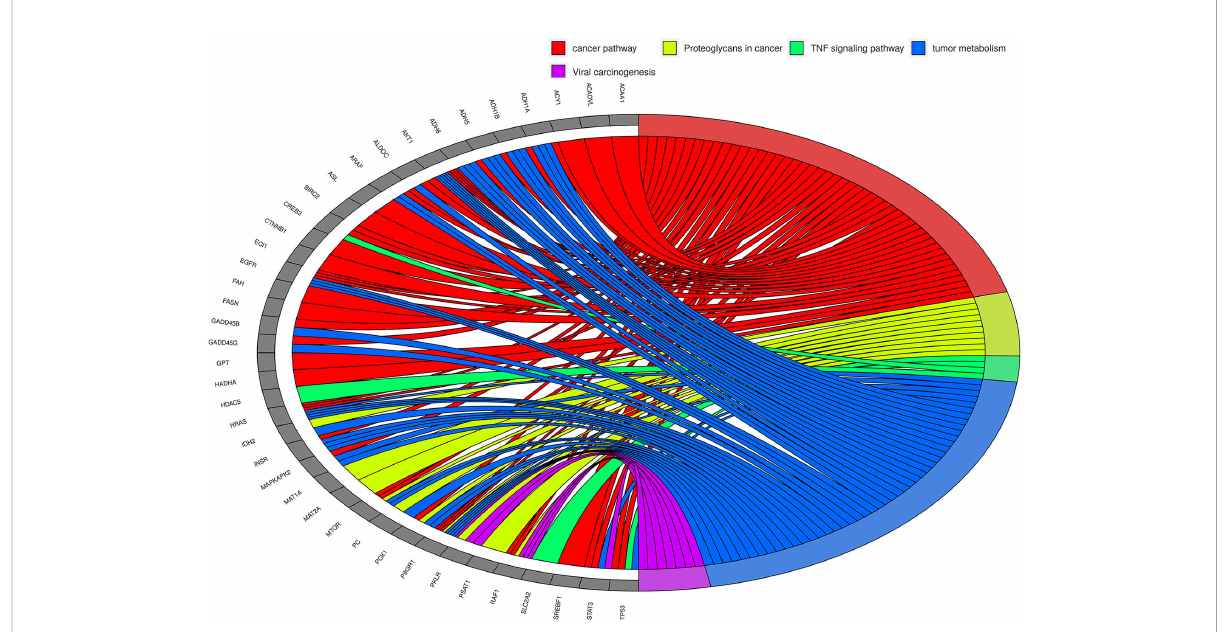
FIGURE 8 The KEGG pathway/Gene Ontology enrichment analyses on top tumor-centric variants. Transcripts carrying tumor-related mutations show clustering of these genes in cancer-related pathways and biological processes. Chord in the diagram indicate the connection between genes (grey blocks at left side) and pathways/processes (colored blocks on the right side). Some pathways/processes were merged for simpli fi cation. As can be seen, metabolism-related genes seem to be predominantly altered in